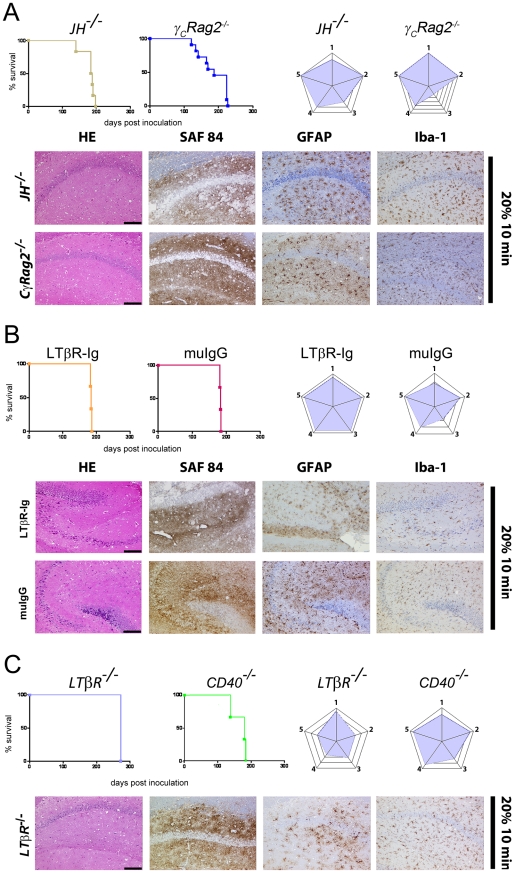
Prion transmission through aerosols in immunocompromised mice.Survival curves, lesion severity score analysis (radar plots), and representative histopathological micrographs of mice with genetically or pharmacologically impaired components of the immune system (JH
−/−, γCRag2
−/−
A),129Sv mice treated with LTβR-Ig or with muIgG (B), and LTβR
−/−, and CD40
−/− mice (C). All mice were exposed for 10 min to aerosolized 20% IBH. Stain code: HE (spongiosis, gliosis, neuronal cell loss), SAF84 (PrPSc deposits), GFAP (astrogliosis) and Iba-1 (microglial activation) as in Fig. 1H. Scale bars: 100µm.